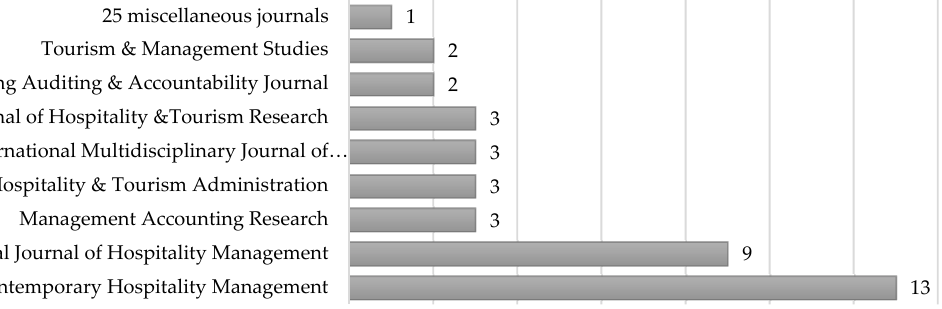
Figure 3. Journals represented in the sample.